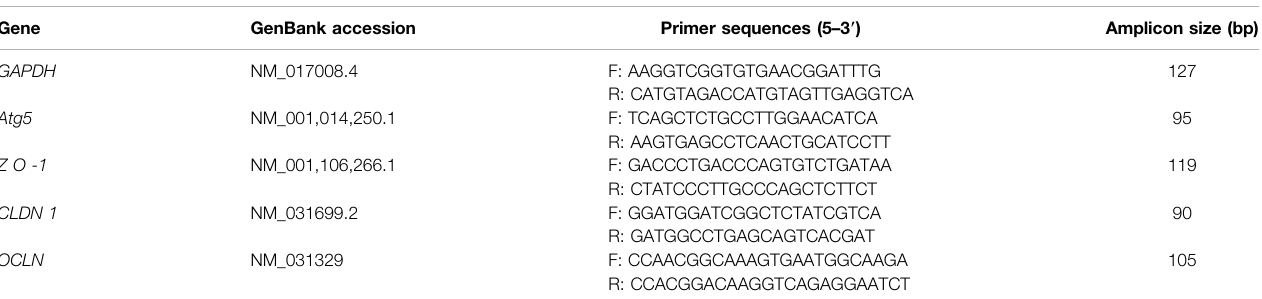
TABLE 2 | Polymerase chain reaction (PCR) primers.